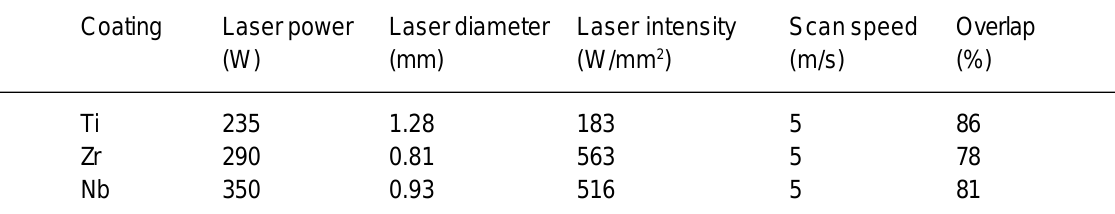
Table 3. Optimum laser processing conditions for each